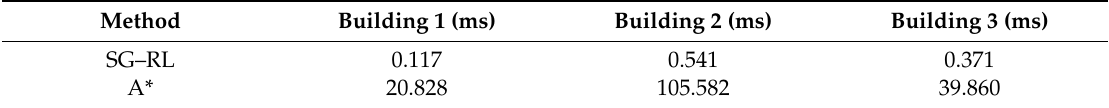
Table 5. H-time of A* and